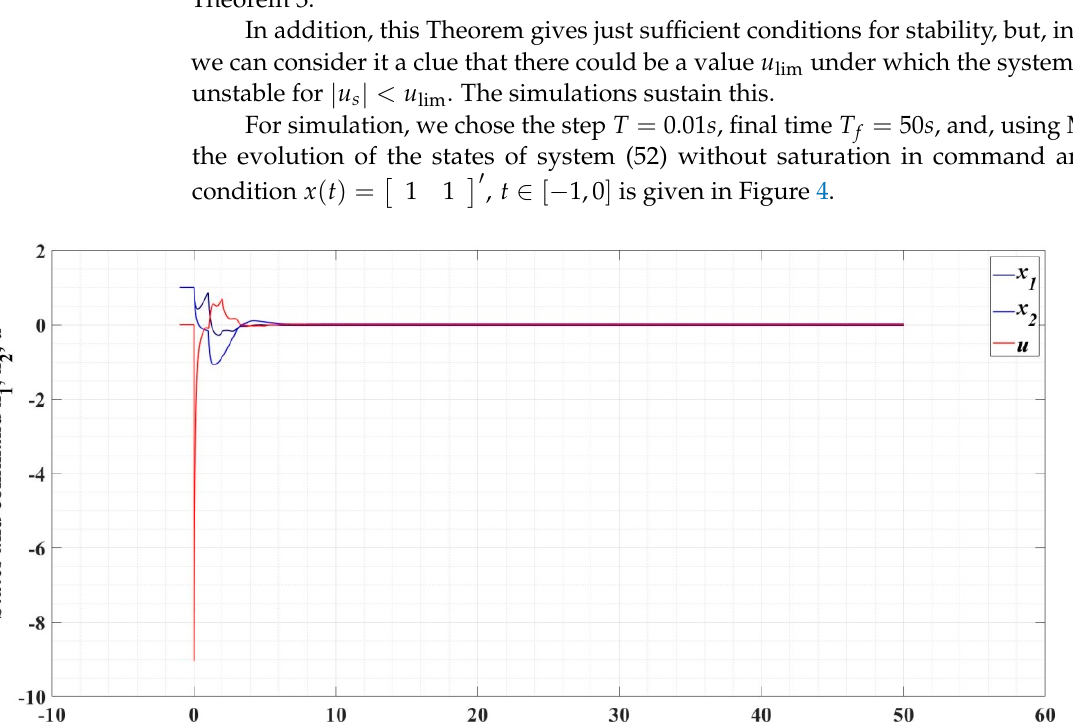
Figure 5. Evolution of the states with 5.0 ≤ u . Figure 6. Evolution of the states with 6271.0 ≤ u . 5.3. Example 3 Consider the system ( S d ) with input saturation and state delay and input delay: